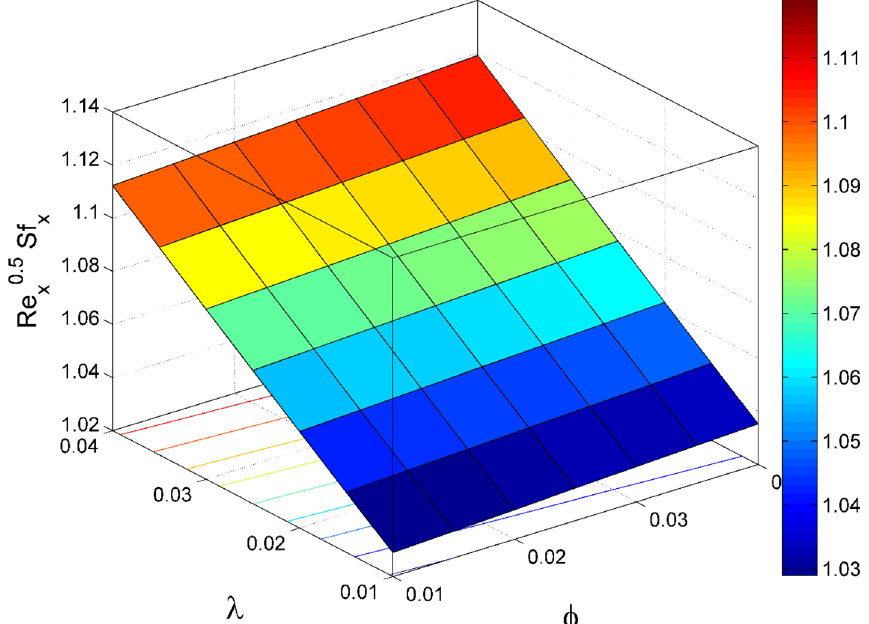
Figure 17. Re 0.5 x Sf x behavior for the variation of nanoparticles volume fraction φ and stretching ratio (cid:31) .